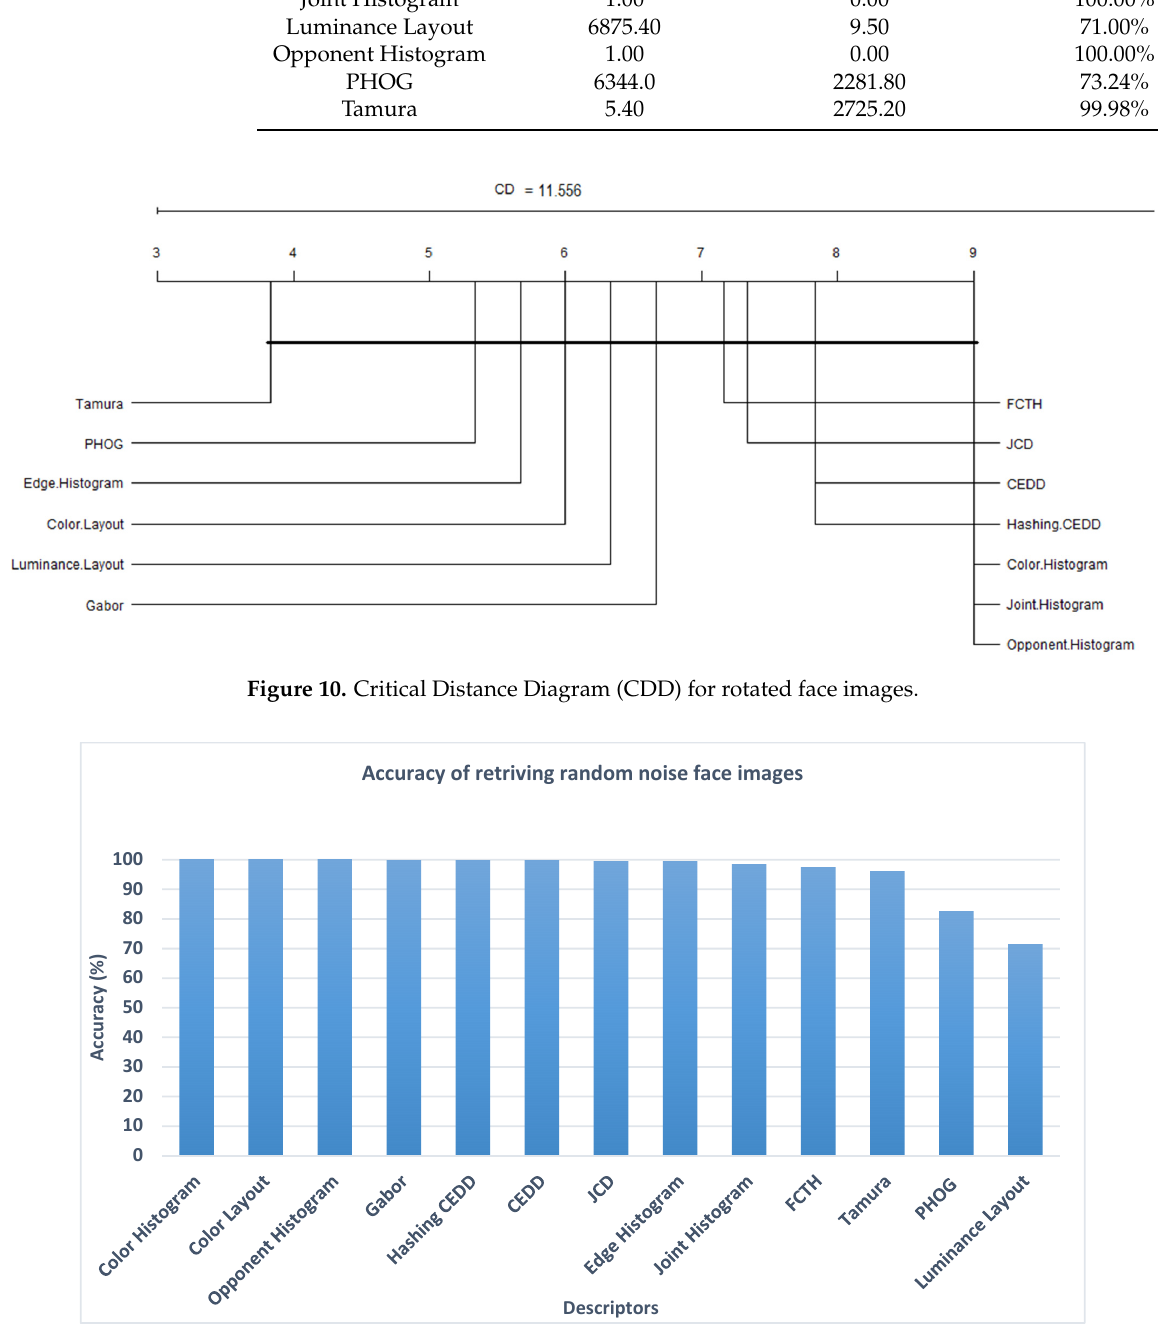
Figure 11. Average accuracy of retrieving random noise face images. Table 4. descriptors’ performance for retrieving random noise-affected face images.